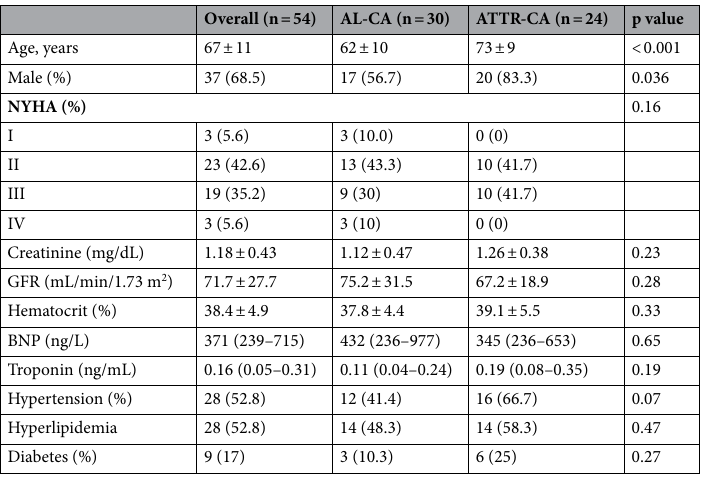
Table 1. Baseline clinical characteristics. Continuous variables are expressed as mean ± standard deviation or median (interquartile range). Categorical variables are presented as n (%). GFR glomerular filtration rate, NYHA New York Heart